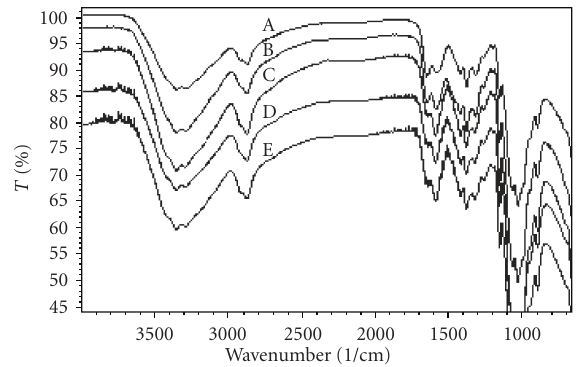
Figure 3: FTIR spectra of CHT1 (A), CHT2 (B), CHT3(C), CHT4 (D) and CHT5 (E).